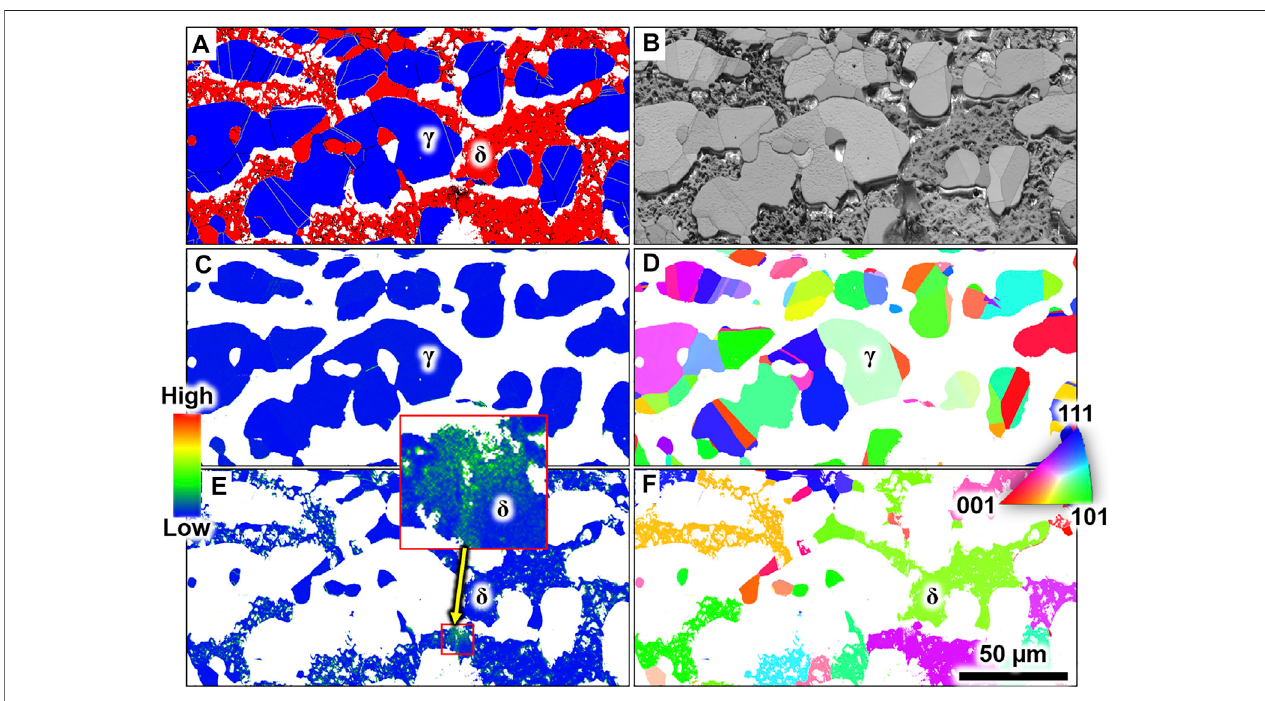
FIGURE 10 | Post-mortem EBSD microstructure analysis after exposure to cathodic hydrogen charging, showing the maps of (A) phase, (B) band contrast, (C) local misorientation oftheaustenite, (D) inverse pole fi gure in thenormal direction ofthe austenite (perpendicularto therollingdirectionand tensile loading axis), (E) local misorientation of the ferrite, and (F) the inverse pole fi gure in the normal direction of the ferrite. The ESBD map was acquired from the centre of the specimen (approximately700 – 800 µmawayfromthesurface)thatwascutalongthetransversedirectionofthetensilespecimen.Hydrogeninfusionoccurredfromallsidesof the maps showing some strain localization for the ferrite only. The scale bar in (F) applies to all maps. The tensile loading axis was along the horizontal axis. The white background in (A) shows non-indexed regions while black lines show low- and high-angle grain boundaries.